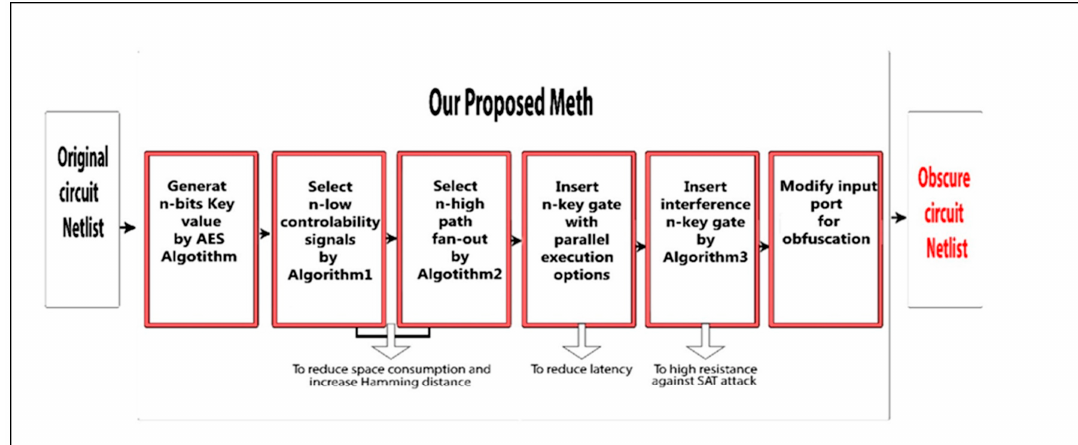
Figure 9. Our proposed